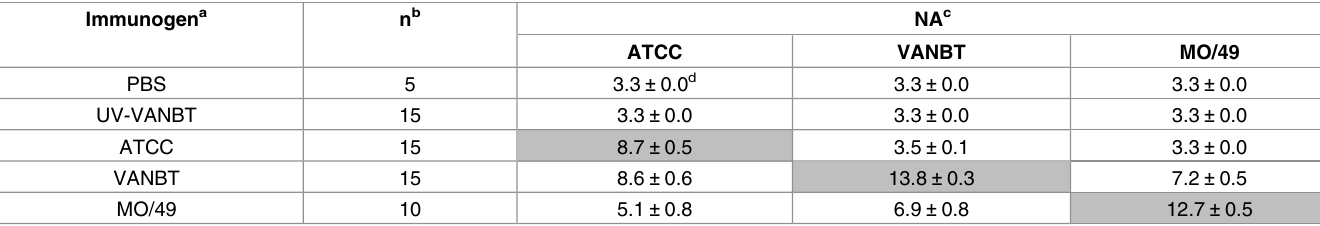
a Female cotton rats were immunized i.m. with 10 6 TCID 50 /100 μ l of indicated virus on day 0 and at 3 weeks. Serum was obtained at 7 weeks. b Number of cotton rats used in each vaccination group. c Geomean ± SE of Log 2 NA titers. Highlighted values represent homologous titers. d Limit of detection of the